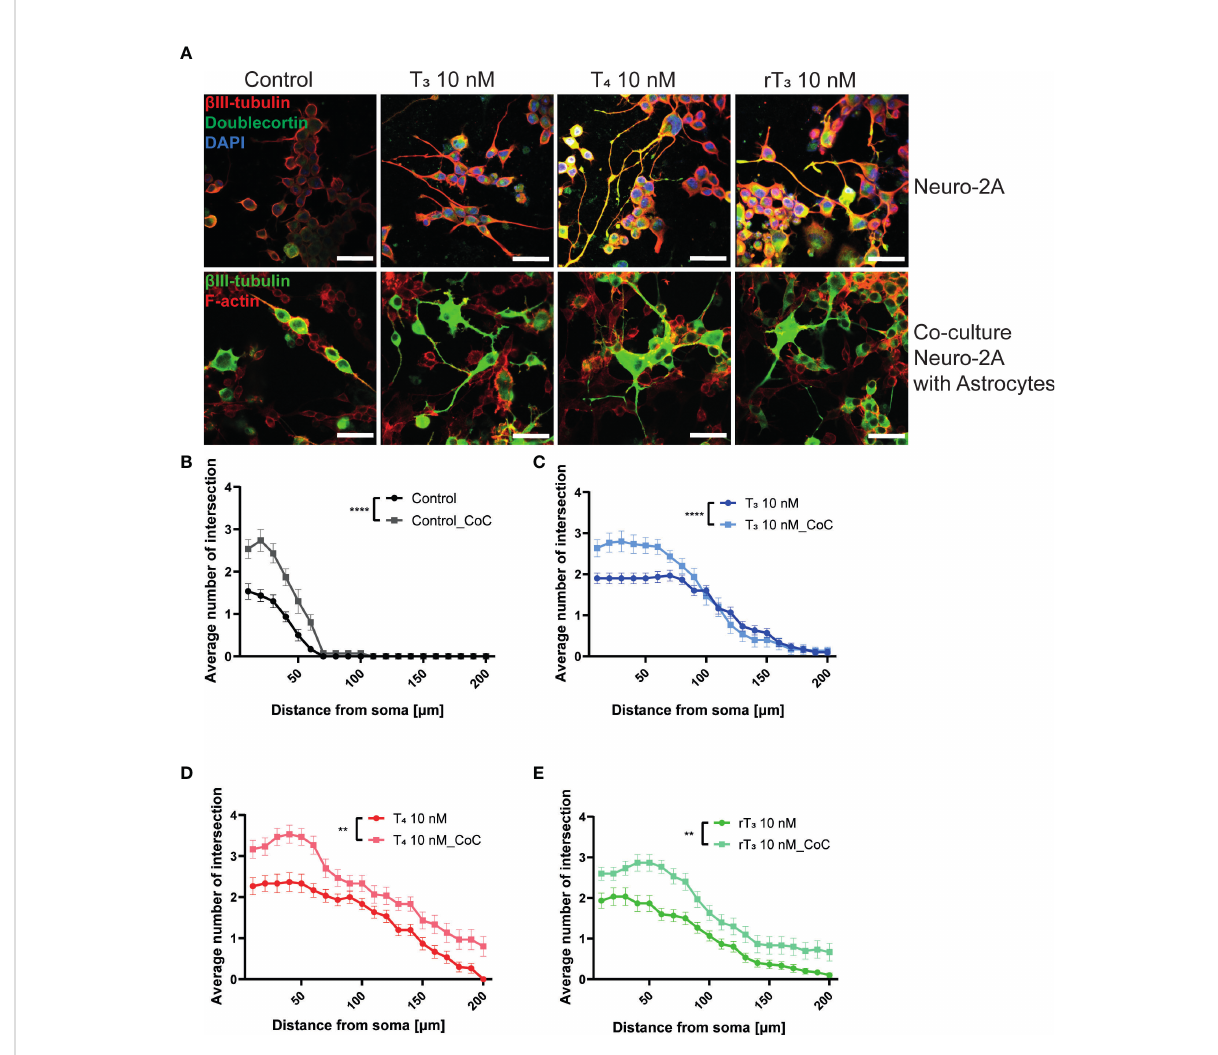
FIGURE 5 Co-culture with astrocytes enhanced TH-augmented neurite length in Neuro-2A cells. (A) Representative photomicrographs showing the effects of TH, with or without co-culture with astrocytes, on the differentiation of Neuro-2A cells. Neuro-2A cell differentiation was induced by serum starvation for one to three days, followed by immunostaining with b -tubulin III (red), doublecortin (green), and DAPI (blue) (upper panel) or b -tubulin III (green) and F-actin (red) (lower panel). Quantitative analysis of the effect of co-culture with astrocytes (B) and exposure to T 3 (C) ,